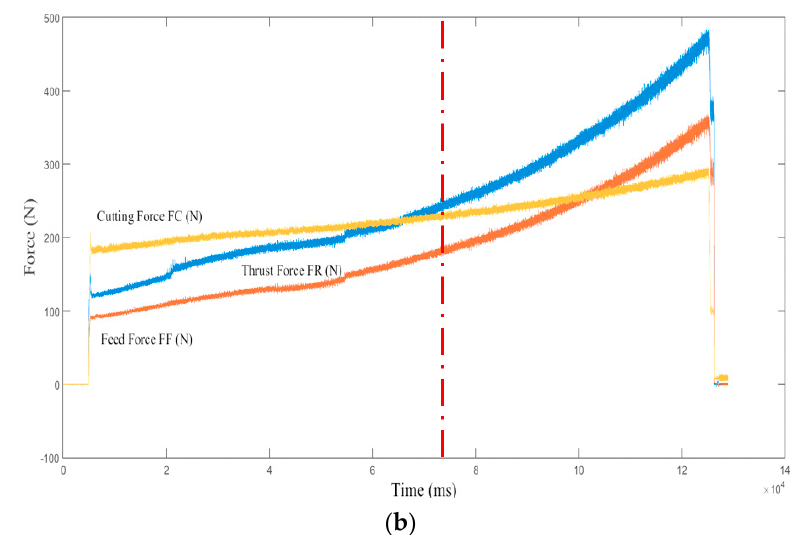
Figure 12. ( a ) Flank wear (VB); ( b ) cutting force profile of insert TS2000 for 120 s of cutting time.